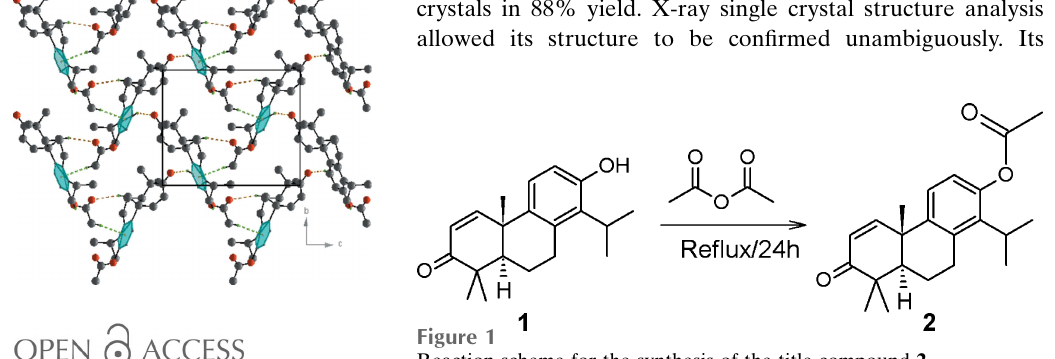
Figure 1 Reaction scheme for the synthesis of the title compound 2